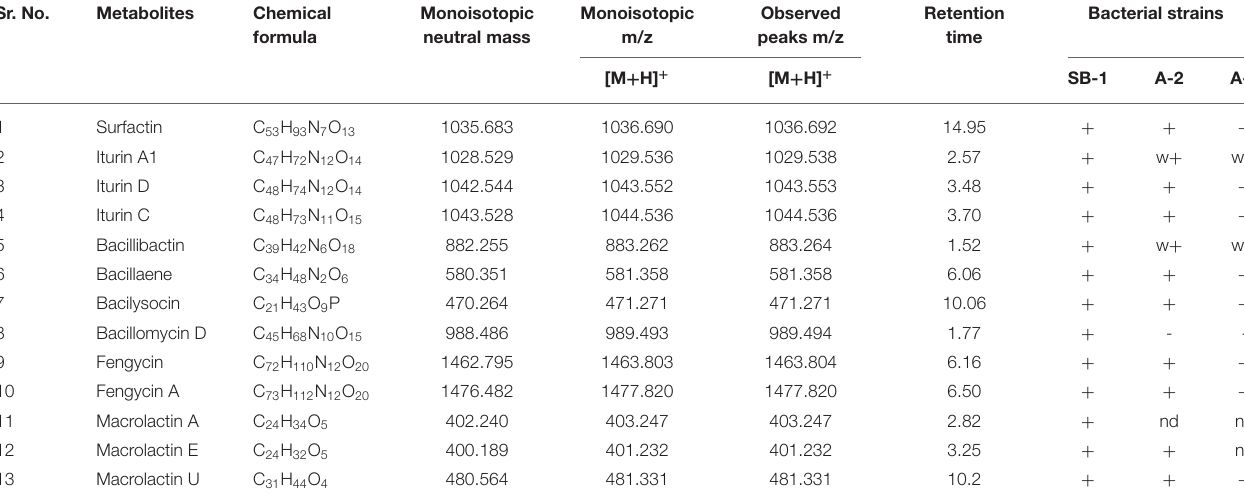
TABLE 2 | Chemical formulas, monoisotopic neutral mass, m/z and observed peaks of detected metabolites. Sr.